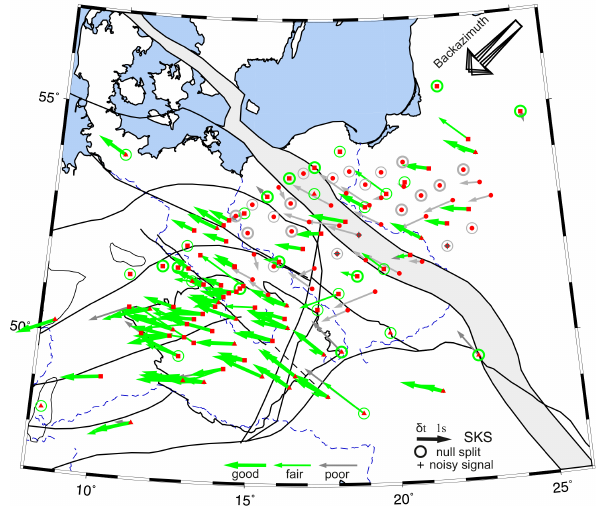
Figure 8. Azimuths ϕ of the fast shear-wave polarizations and the split-delay times δt evaluated for three events from the NE back azimuths. Anisotropic signal dominate in the Bohemian Massif, null splits or small provinces with coherent polarizations exist west and north of the Bohemian Massif. Complementary measurements at stations equipped with 2–3s seismometers are shown in light-grey